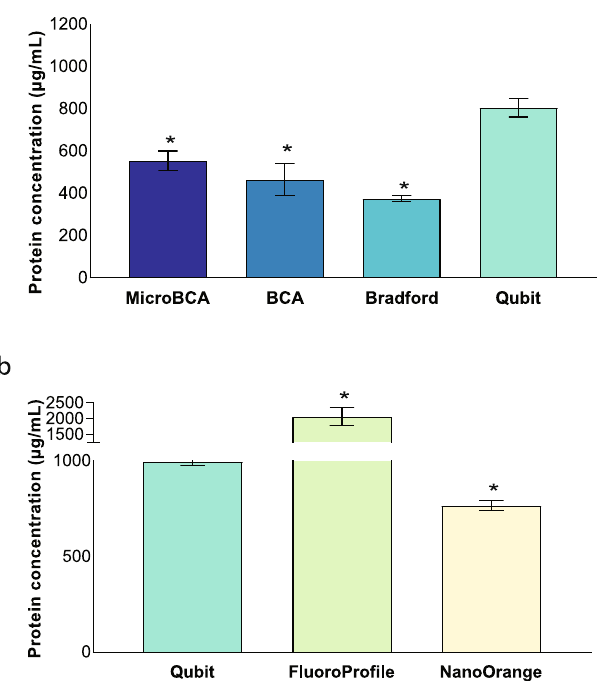
Figure 5. Performance of different protein assays to measure protein concentration of EV samples. ( a ) Protein quantification for one EV sample using three colorimetric assays (MicroBCA, BCA, Bradford) was performed opposed to one fluorometric assay (Qubit) (n = 3, * p < 0.003). ( b ) All fluorometric assays (Qubit, FluoroProfile, NanoOrange) were tested on another EV-sample (n = 3, * p < 0.005). Mean values + SD are indicated. Significant differences were calculated using Student’s t-test with Qubit as reference. Abbreviations: EV: extracellular vesicle. BSA: bovine serum